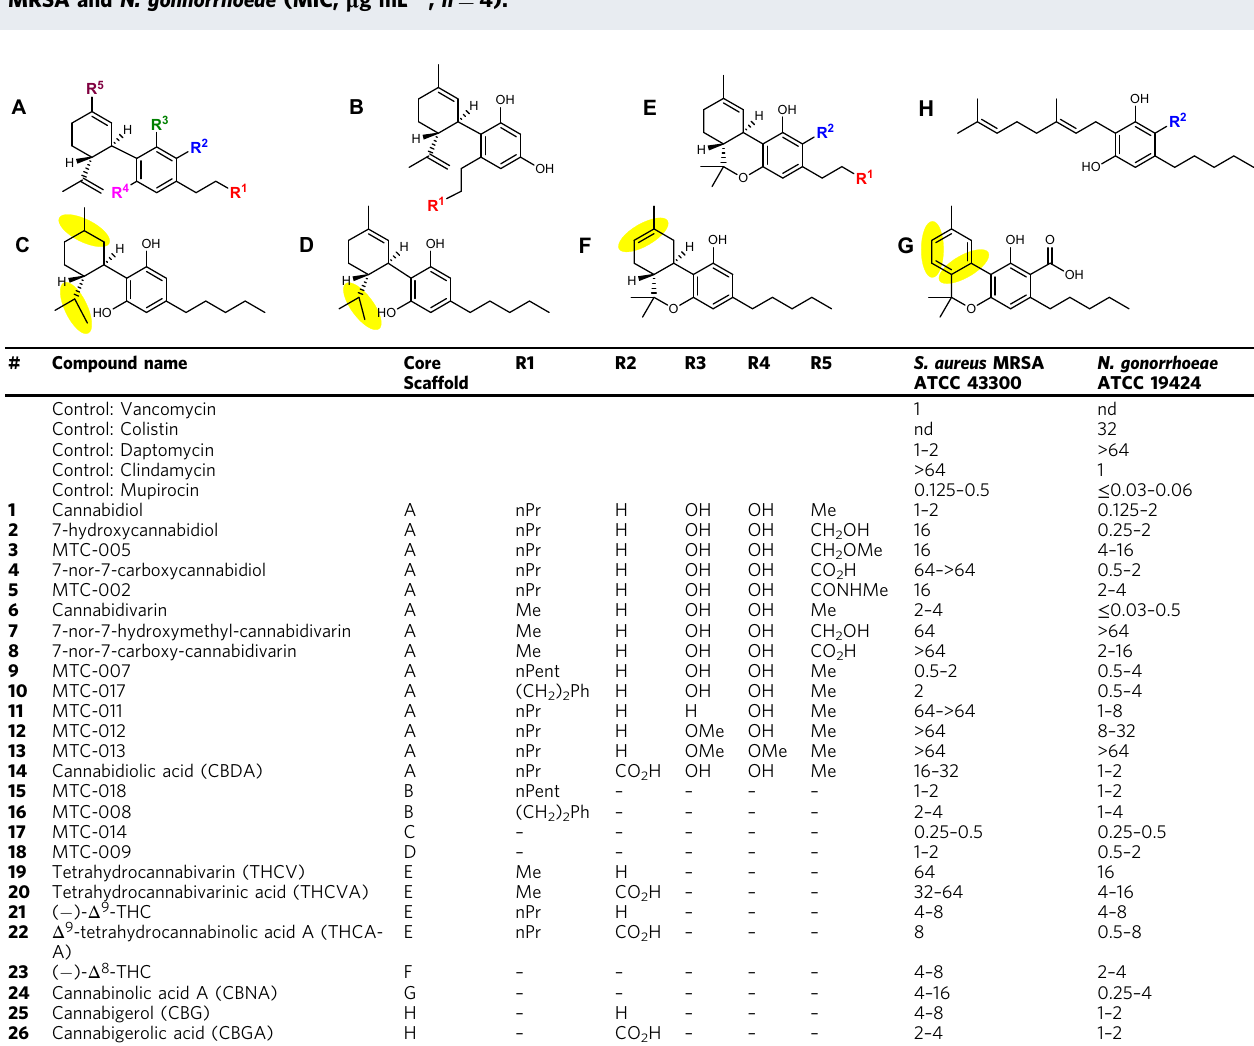
Table 2 Structure of CBD analogs and summary of effect of modi fi cation to different positions on antimicrobial activity